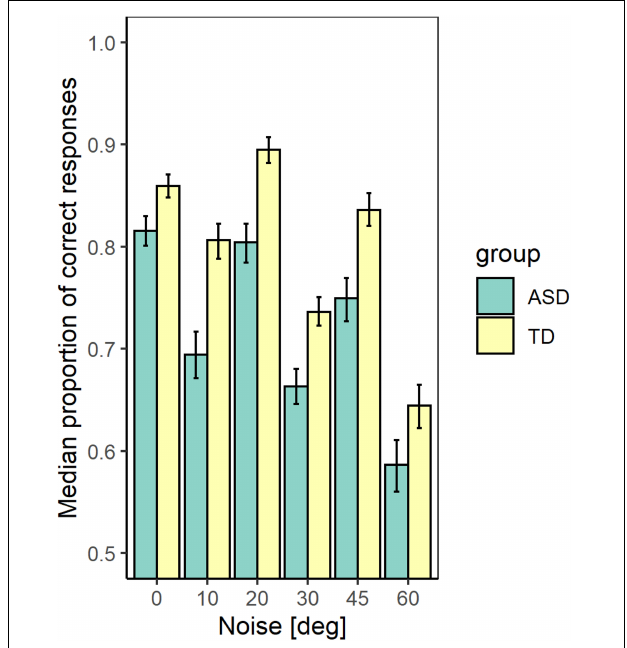
FIGURE 2 | The median values of the proportion correct responses for the two groups with different development at different noise levels. The error bars correspond to the 2.5 and 97.5% values of a bootstrap sample of size